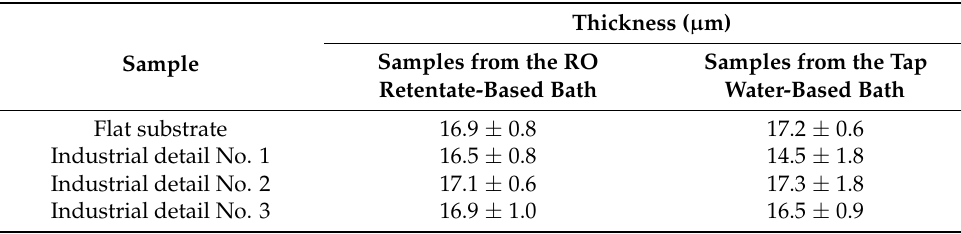
Table 5. Results of thickness measurements of zinc